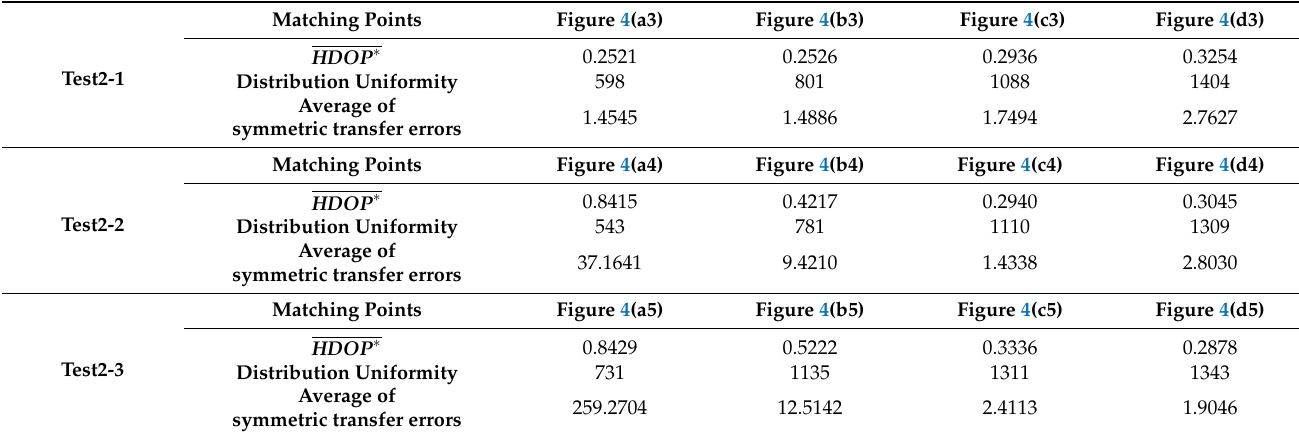
Table 2. Results calculated by the matching points in Experiment